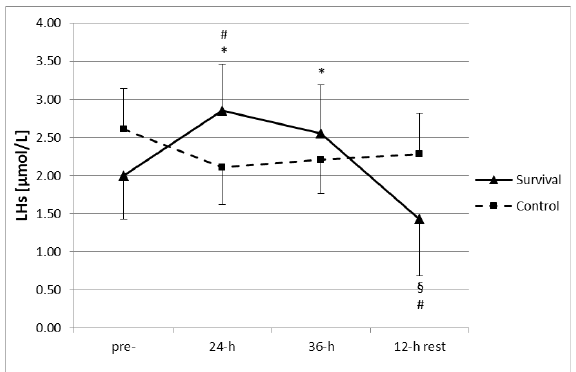
Figure 1. Changes in plasma concentration of lipid hydroperoxides (LHs) (µmol/L) in control group ( n = 11) and survival group ( n = 12) (i.e., 36-h survival training with subsequent 12-h rest period). Values are means ± SD. Main effects: time ( p = 0.006); group × time ( p = 0.00008); * significant difference ( p < 0.05) as compared to pre-training (within same group); § significant difference ( p < 0.05) as compared to pre-training, 24-h, and 36-h (within same group); # significant difference ( p < 0.05) between survival and control groups (at same time